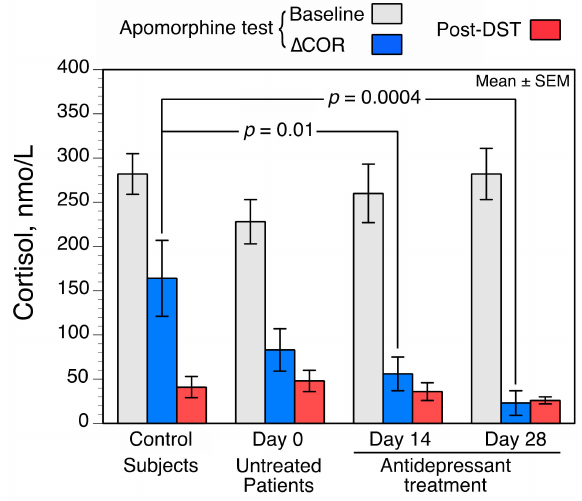
Figure 1. Cortisol values before (i.e., baseline, COR BL ) and after 0.75 mg subcutaneously (SC) of apomorphine (i.e., ∆ COR), and dexamethasone (i.e., post- dexamethasone suppression test (DST) COR max ) in controls ( n = 18) and in depressed patients ( n = 16). Comparison between controls and patients was by Mann–Whitney two-tailed U test.